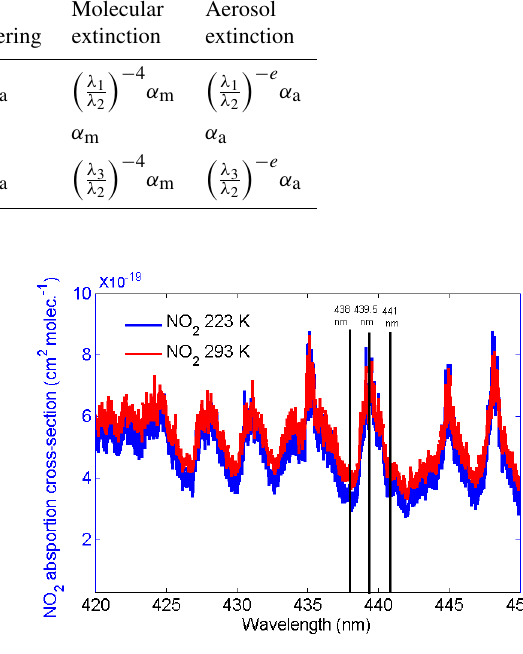
Figure 2. NO 2 strong-absorption cross-section between 420 and